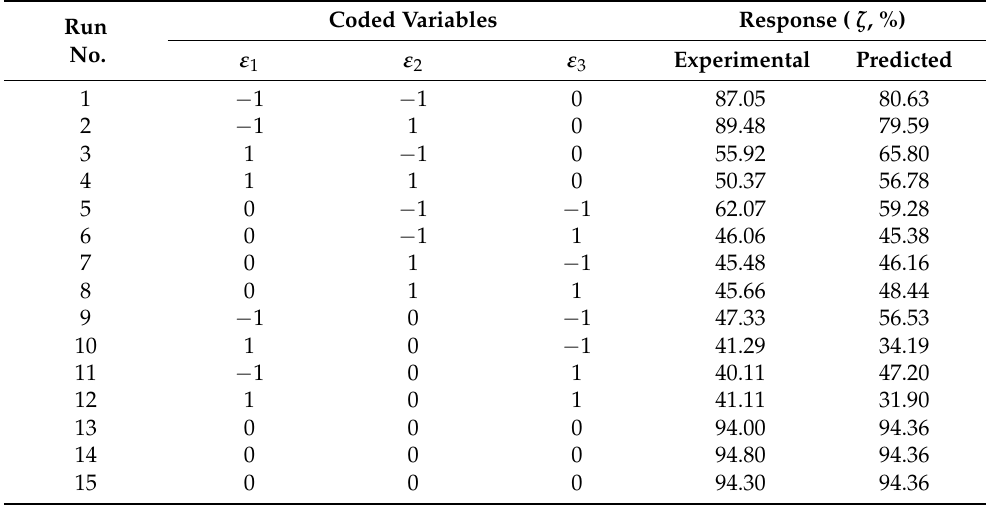
Table 2. Box–Behnken experimental design of WSD:Mag-based oxidation system of the three experi- mental variables in coded units and experimental and predicted